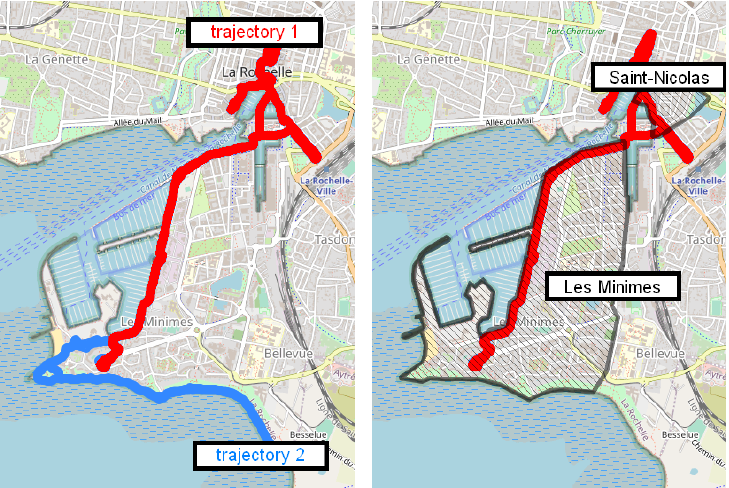
Figure 4. On the ( left ), result after the service temporal trajectories building, on the ( right ), result after the service thematic